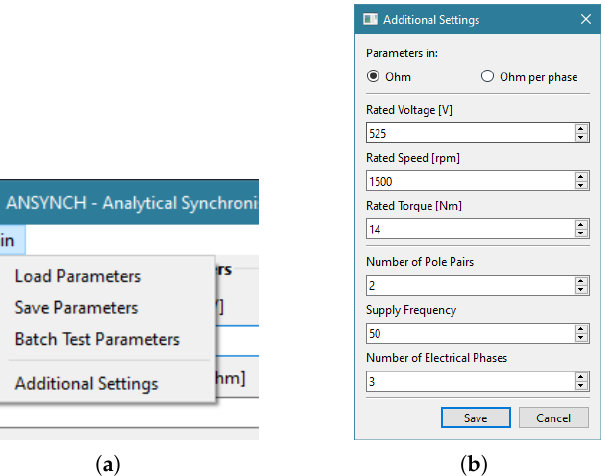
Figure 22. Additional program features: ( a ) menu connecting to additional features and settings, ( b ) additional settings